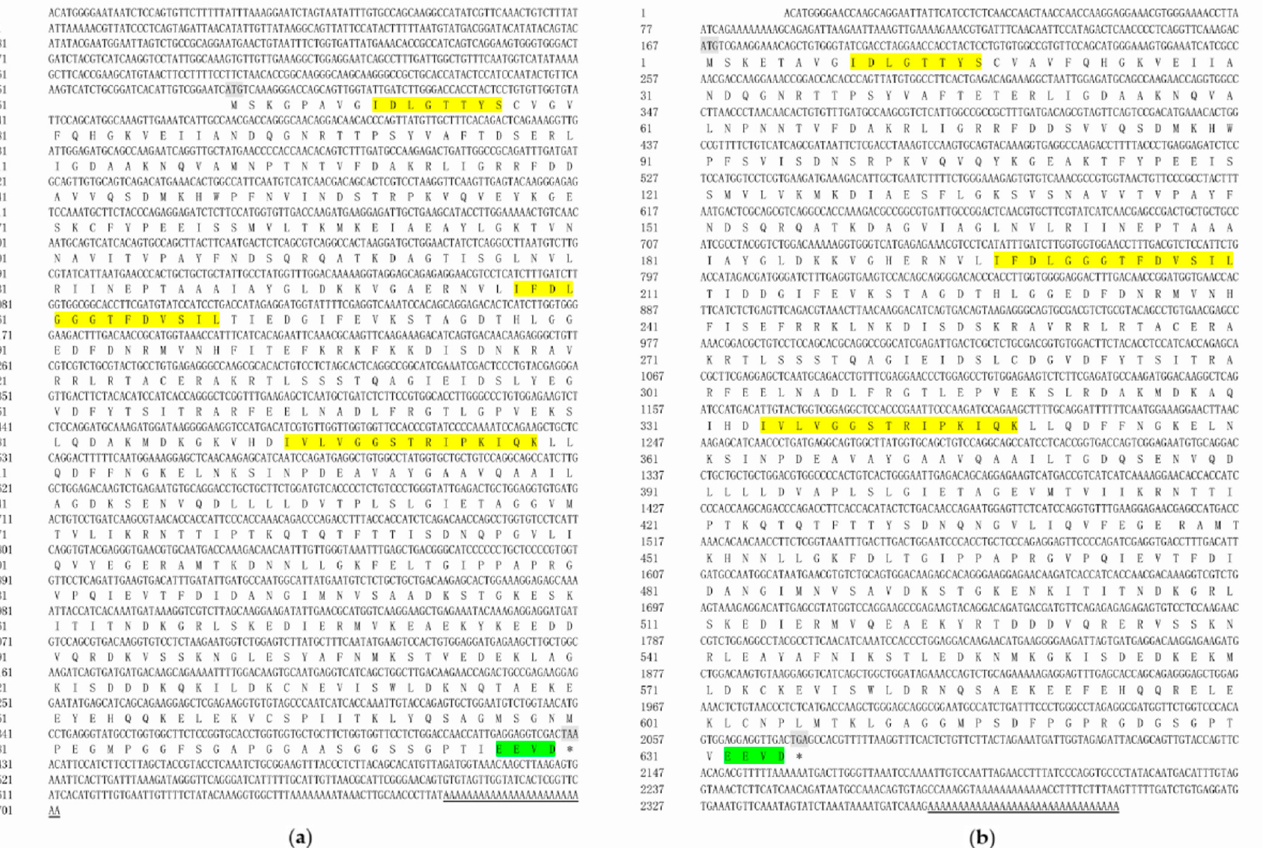
Figure 1. Full-length cDNA and predicted protein sequences of C. semilaevis hsc70 and hsc70-like genes. ( a ) The mRNA and predicted protein sequence of hsc70 ; ( b ) The mRNA and predicted protein sequence of hsc70-like . The yellow shadows represented the conserved sequences of the HSP70 family, the green shaded EEVD is the cytoplasmic motif in the C-terminal region, the grey shadows represented the initiation codon and termination codon, and the asterisk (*) represented the termination codon. The poly (A) tail was underlined.